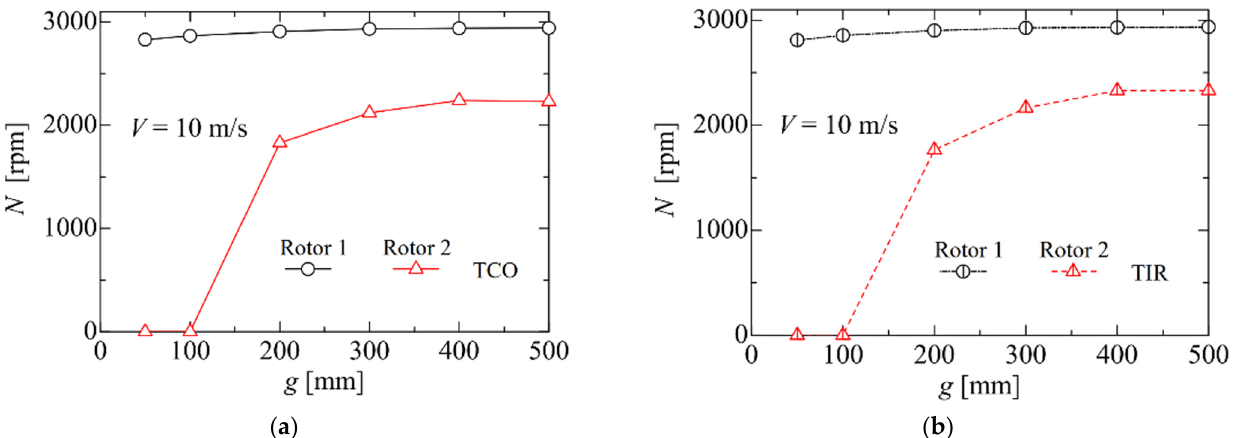
Figure 10. Variations in rotational speed with the gap between the rotors in tandem layouts at V = 10 m/s: ( a ) TCO; ( b ) TIR.